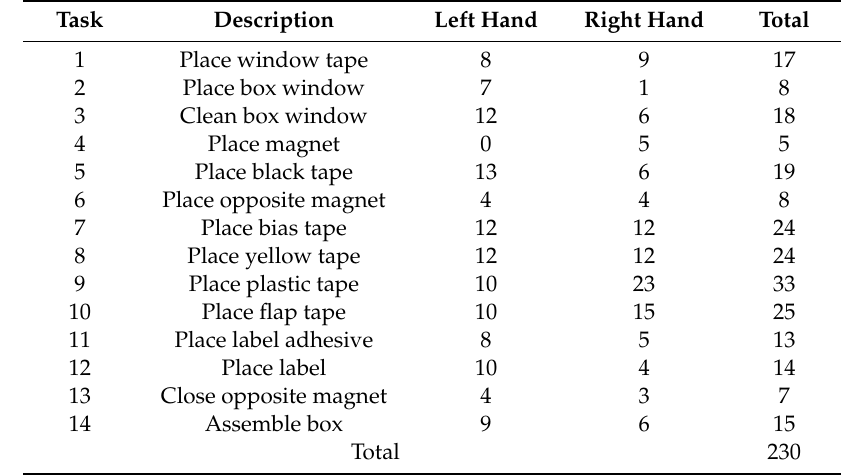
Table 4. Ine ffi cient therbligs in original work method.